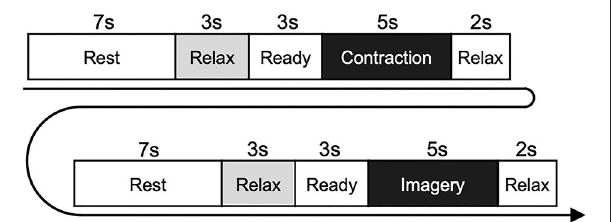
FIGURE 1 | Experimental paradigm of the physiological experiment. Participants performed isometric contraction in the contraction phase and performed motor imagery of the same movement in the imagery phase. The diagram shows the flow in each trial, which was repeated five times within each set. Six sets were performed for each of the wrist dorsiflexion and shoulder abduction tasks.